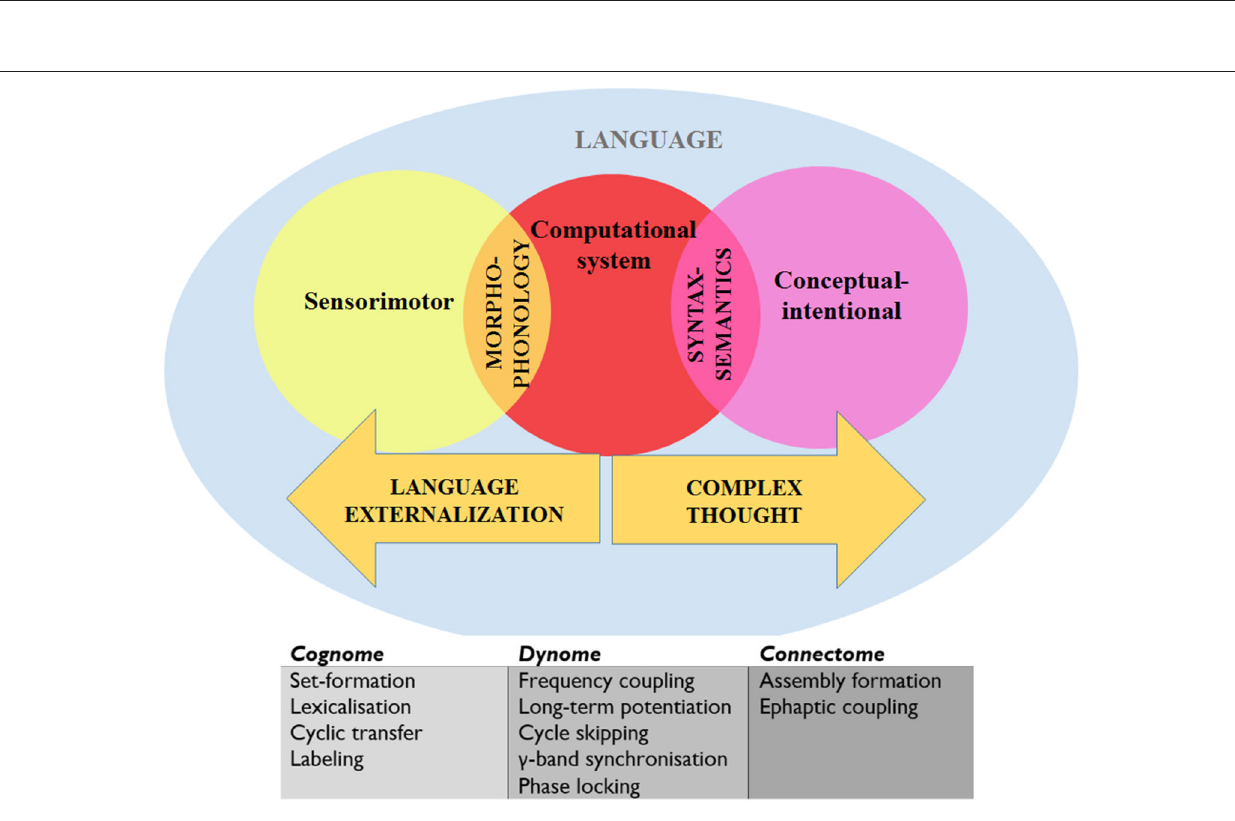
FIGURE 5 | A schematic view of language representing the systems and interfaces of interest and the levels of analysis. “Cognome” refers to the operations available to the human nervous system (Poeppel, 2012) and “dynome” refers to brain dynamics (Kopell et al., 2014; Murphy and Benítez-Burraco, in press). See text for